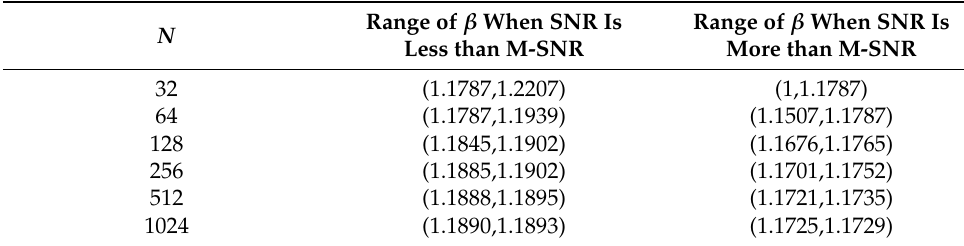
Table 6. The value range of β in different code lengths.